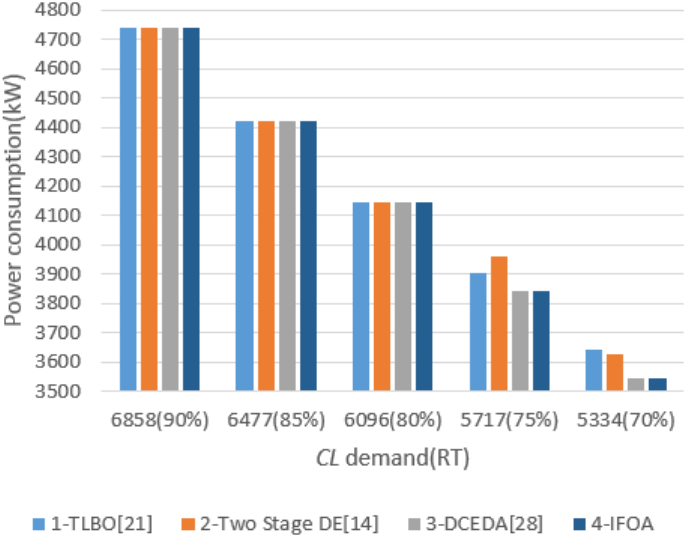
Figure 4. Histogram representation of results of in case 1. Table 6. Results of objective function in 30 runs in case